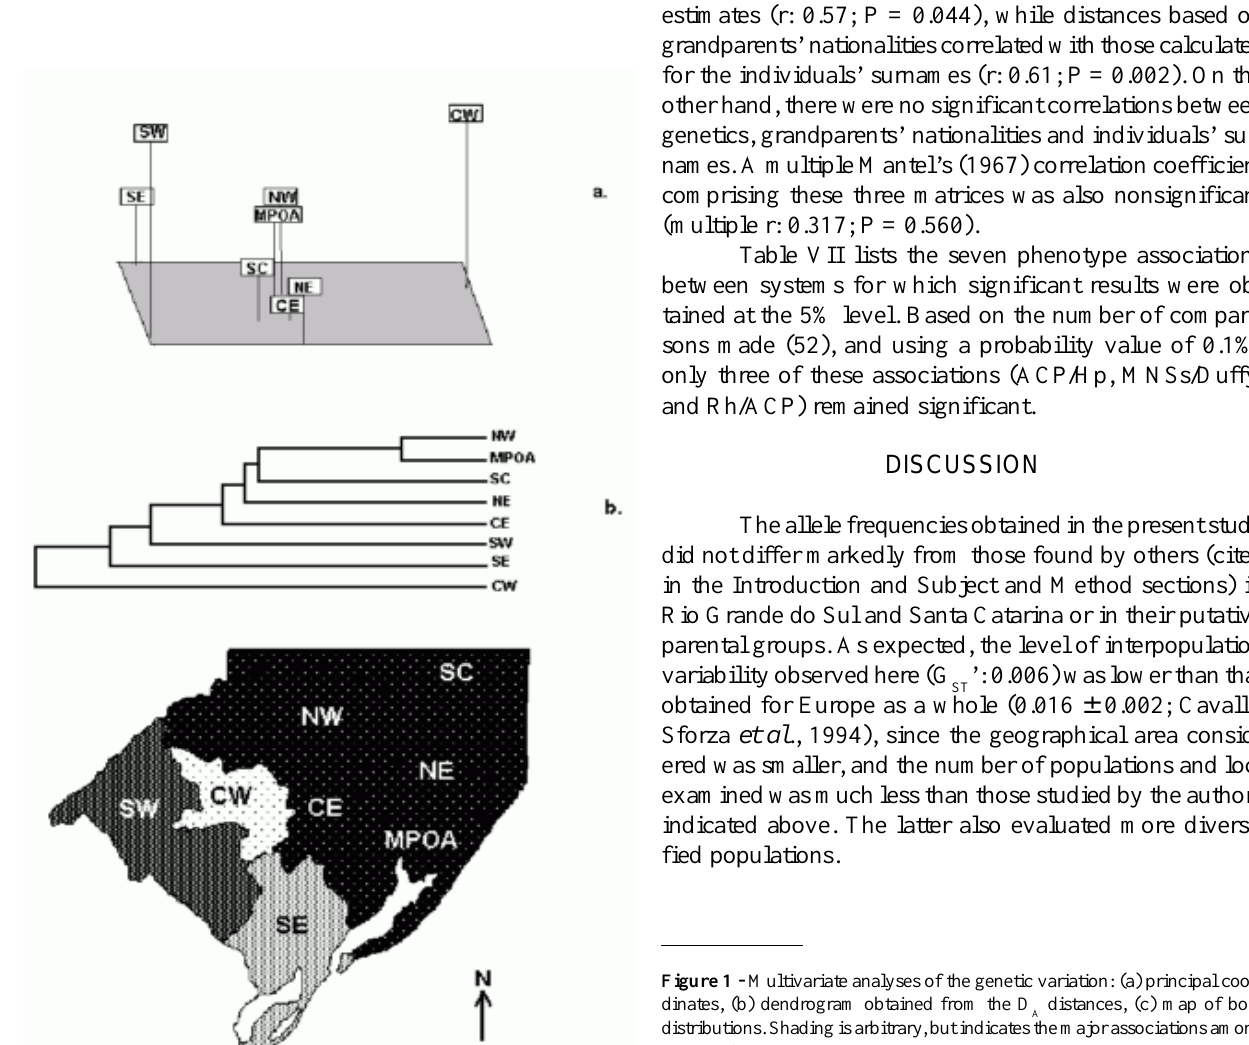
Figure 1 - Multivariate analyses of the genetic variation: (a) principal coor- dinates, (b) dendrogram obtained from the D distributions. Shading is arbitrary, but indicates the major associations among